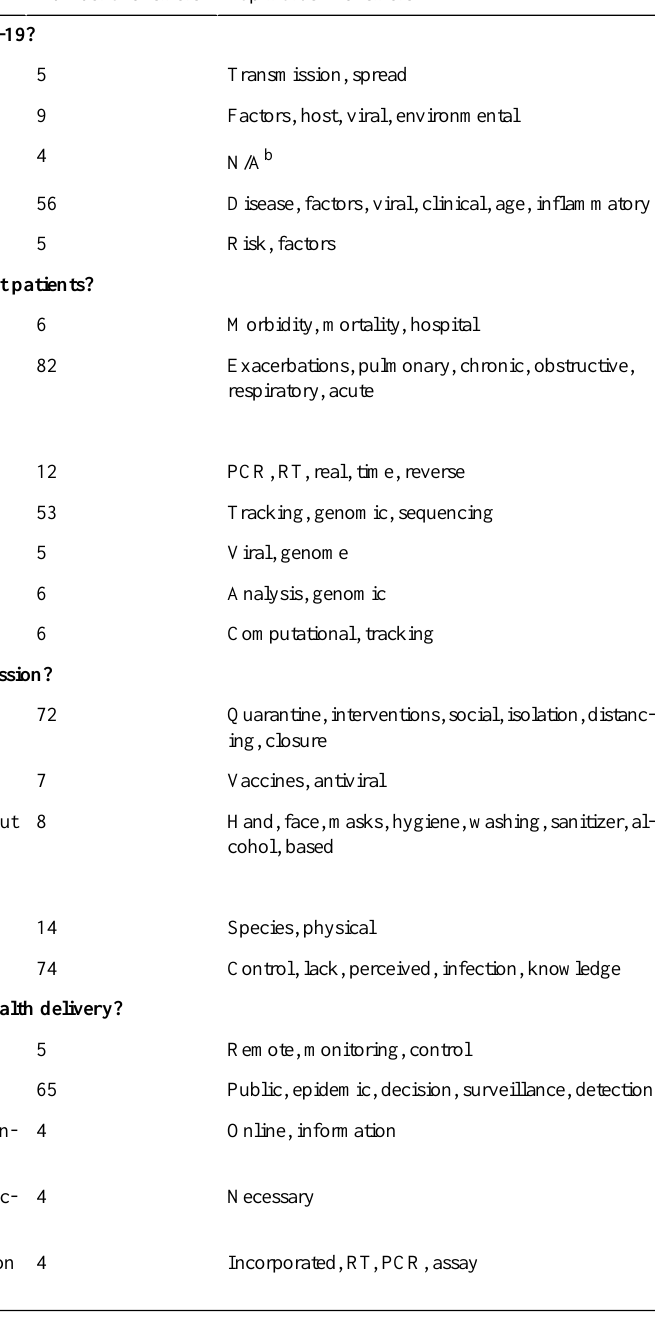
Top words in answersNumber of answers a Question and opinion Transmission, spread51. Transmission and spread Factors, host, viral, environmental92. Environmental factors